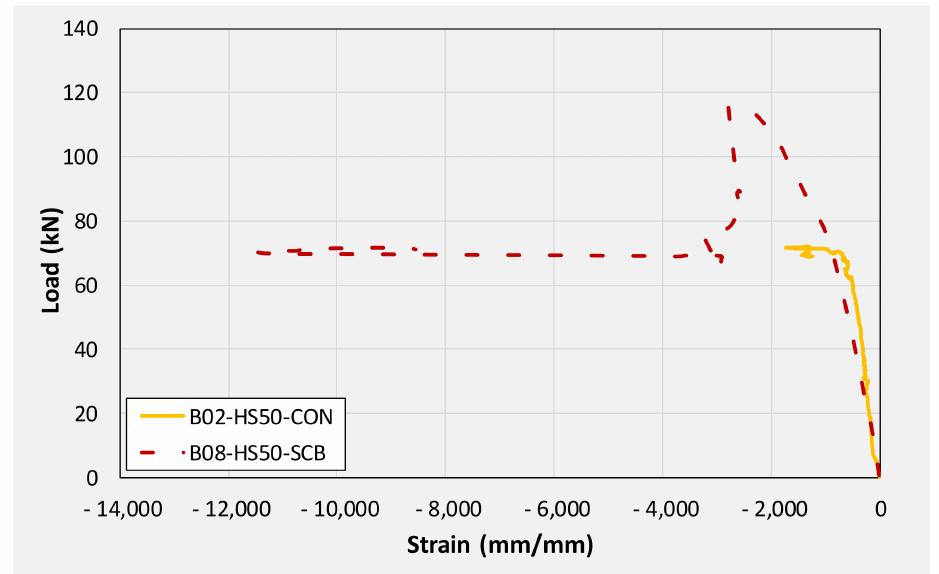
Figure 25. Monitored negative steel strain in beams with 50 mm internal square